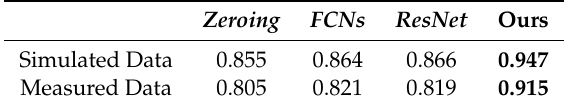
Table 4. Performance Comparison for Human Activity Recognition with the Restored